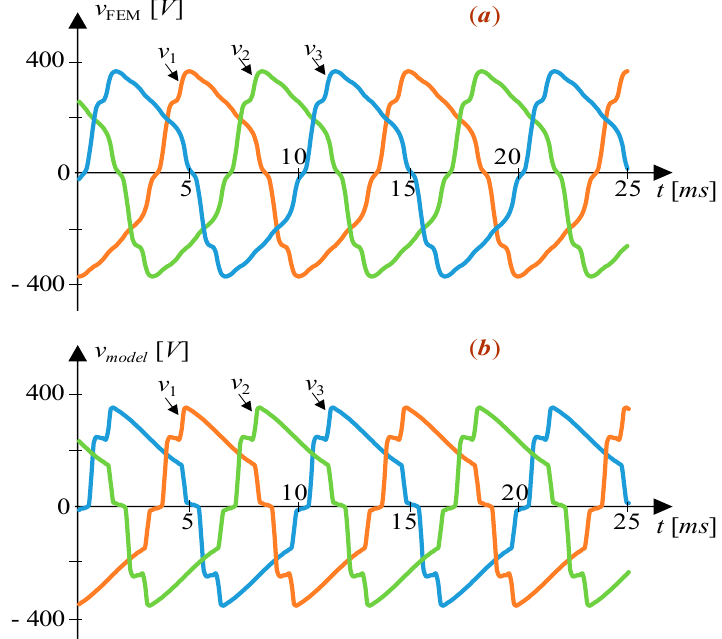
Figure 11. Armature voltages in rated load conditions at steady state; ( a ) results of FEM analysis; ( b ) results from theoretical model.